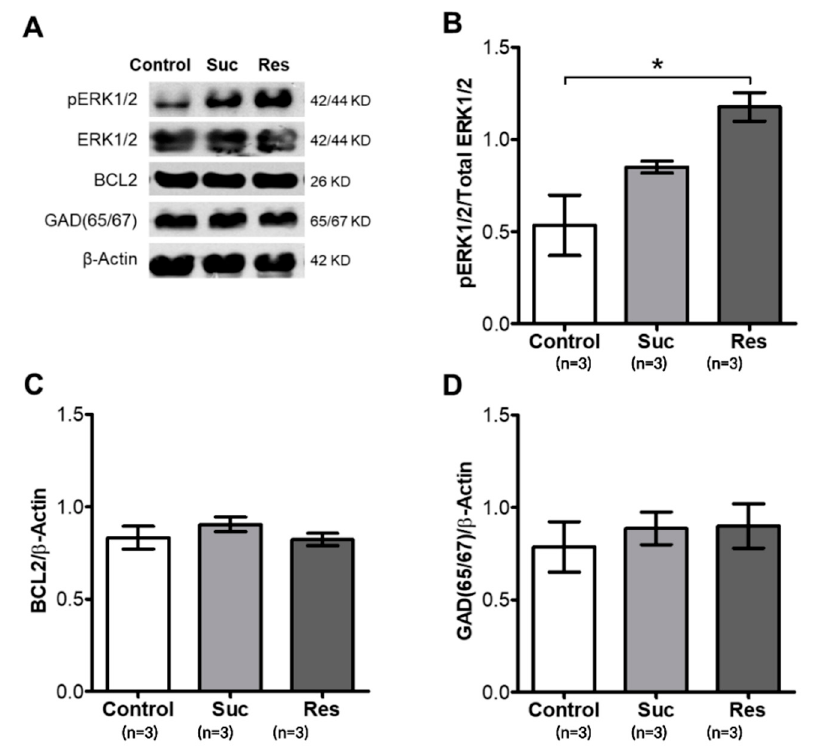
Figure 11. Sucrose exposure restricted to the late adolescence increases ERK1/2 phosphorylation in the hippocampus. ( A ) Representative images of Western blots for protein analyzed. ( B ) The densitometry of phosphorylated levels of ERK1/2, normalized by total ERK1/2. ( C ) BCL2. ( D ) Glutamate Decarboxylase (GAD65/67) in all the experimental groups. One-Way ANOVA and Tukey test, * p < 0.05.